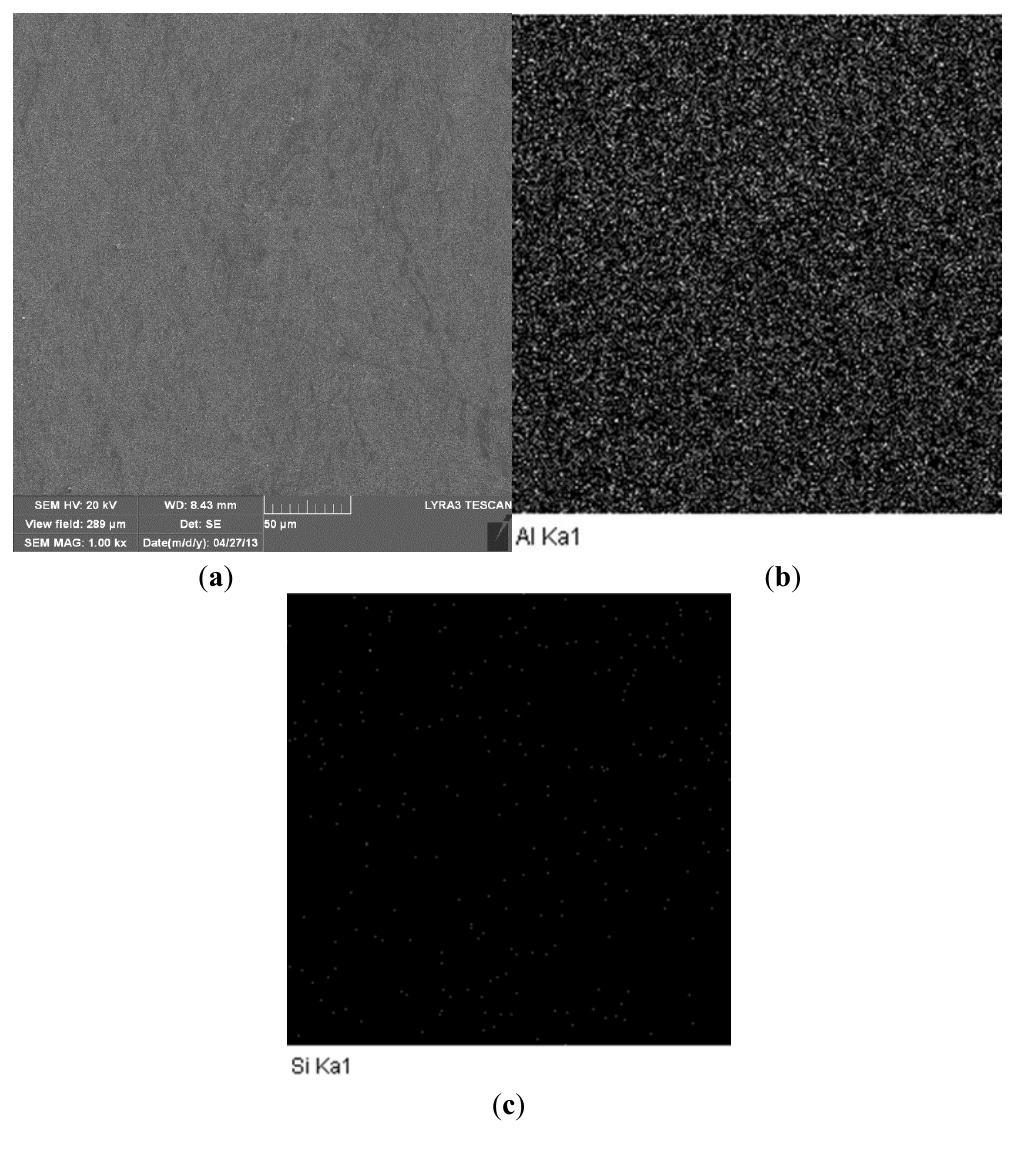
Figure 7. ( a ) SEM micrograph and corresponding X-ray mapping of ( b ) Al and ( c ) Si of specimen sintered at 600 °C for 10 min using 50 MPa and 200